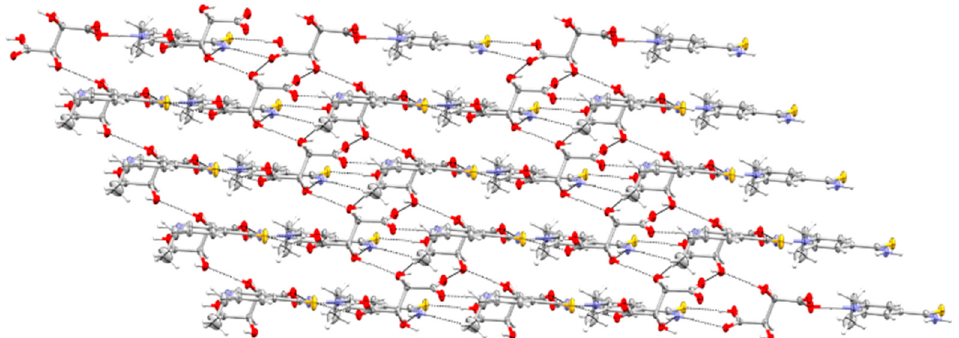
Figure 6. HB interactions between chains in ETN · TAR.